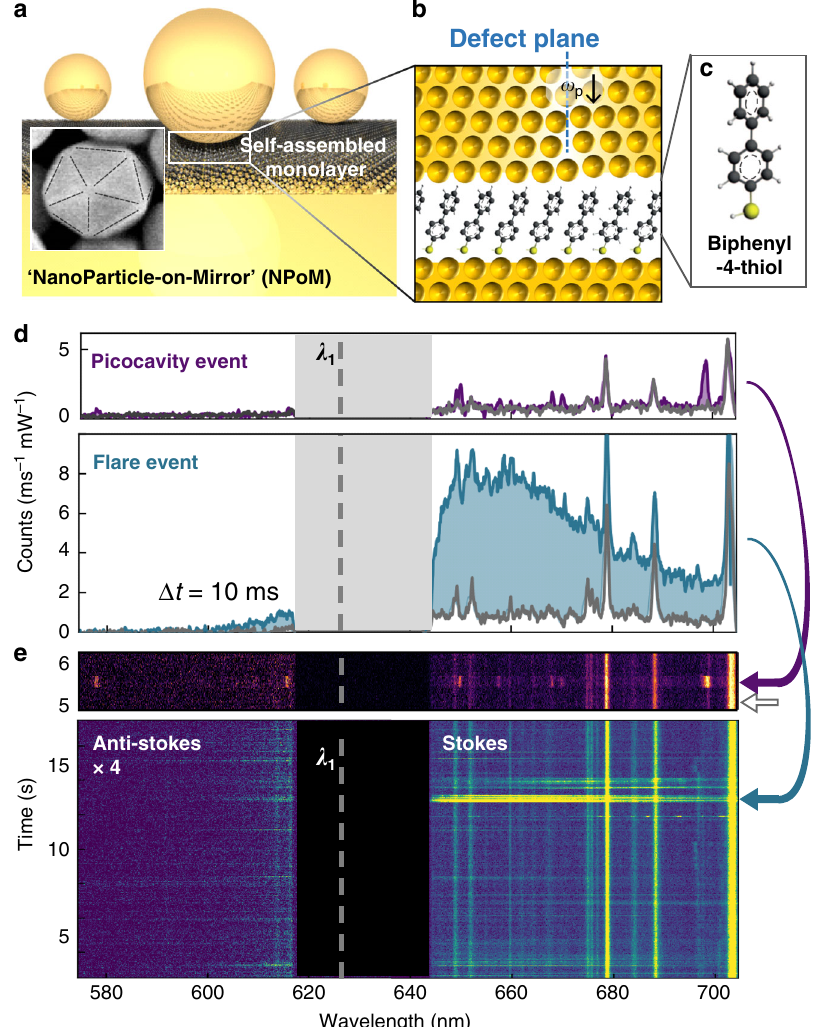
Fig. 1 Flares and picocavity transient events in plasmonic nanocavities. a Nanoparticle-on-Mirror construct, sandwiching a molecular monolayer. Inset shows typical icosahedral nanoparticle, with twin planes dashed. b Schematic transient defect boundary (dashed) at surface facet of nanoparticle. c Biphenyl-4-thiol (BPT) molecule making up monolayer (for others see below). d Inelastic scattering spectra; top panel shows picocavity event (purple), bottom panel shows broad fl are spectrum (blue), each compared to stable BPT spectra from same nanoparticle (grey). e Kinetic SERS spectra showing time dynamics of picocavity spectra (top panel, purple arrow) and multiple fl are spectra (bottom panel, blue arrow identi fi es fl are spectrum in d